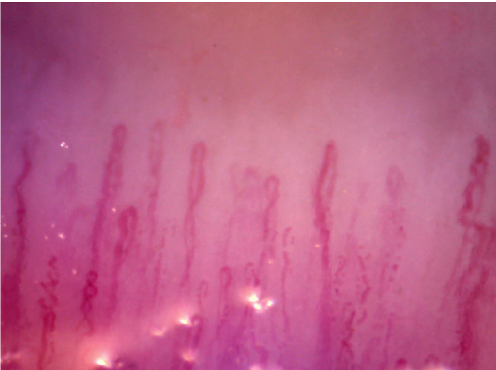
Figure 1: Normal pattern capillaroscopy adequate density without the presence of giant capillaries, avascular areas, or